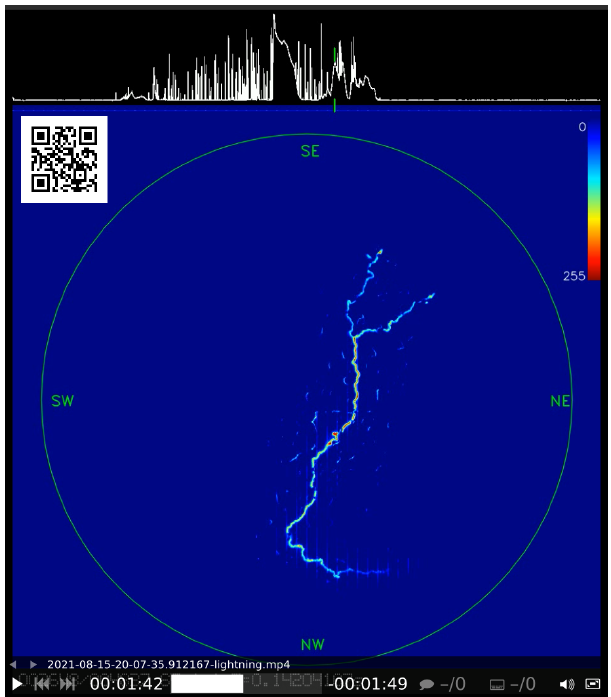
Figure 21. The reader is advised to use the inset QR code or the following link to run the video: https://doi.org/10.5446/60388 (Kakona,